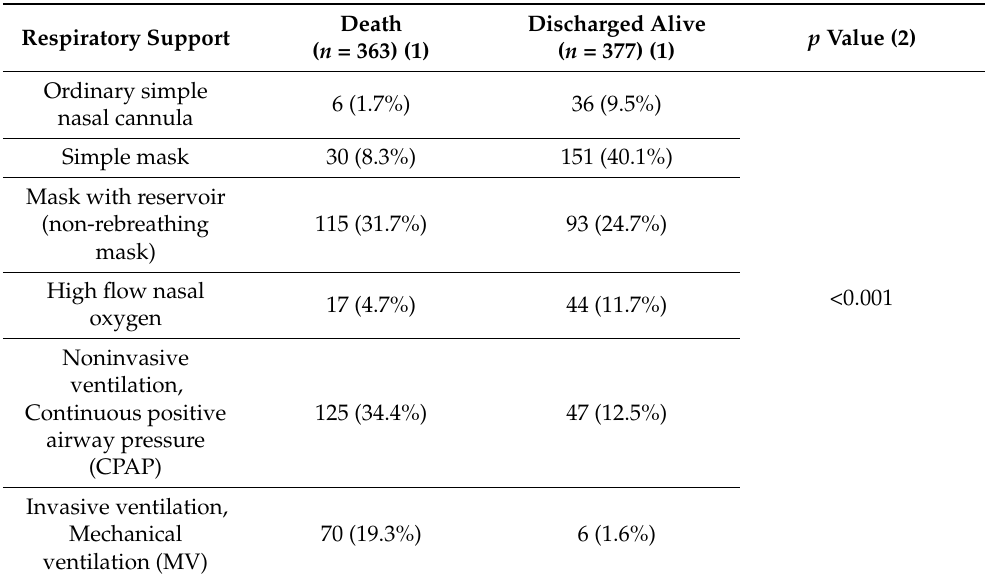
Table 6. Distribution of respiratory support at the time of hospitalization regarding the primary outcome.